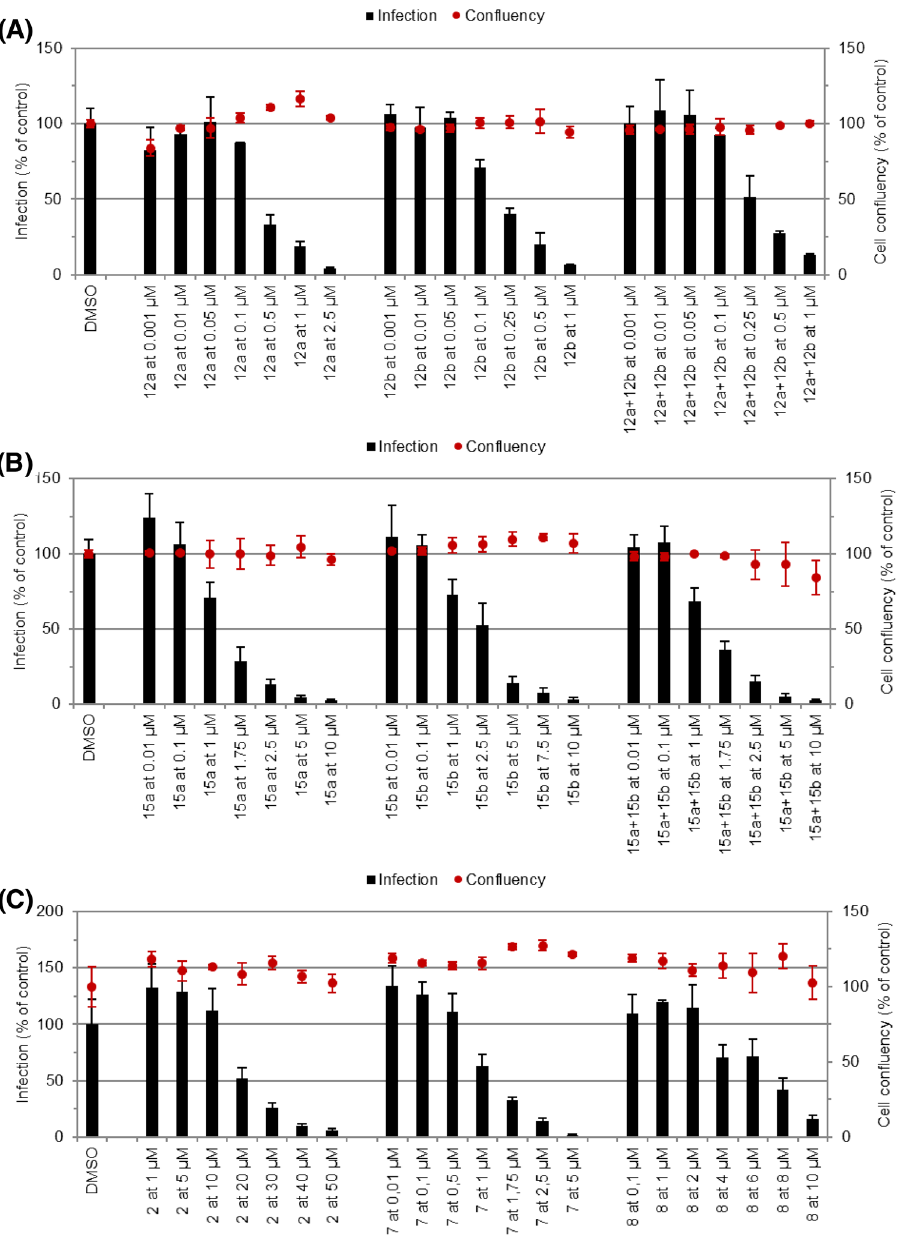
Figure 10. Dose-dependent response of compounds against the hepatic stage of P. berghei infection. The dose- dependent response of ( A ) IVM-CQ hybrids, 12a , b ( B ) IVM-PQ hybrids, 15a , b , and ( C ) 7 , 8 and standard drug 2 were evaluated against P. berghei- infected Huh7 cells. Total parasite load (infection scale, bars) and cell viability (cell confluence scale, dots) are shown, n ≥ 2. Calculated IC 50 values are shown in Table